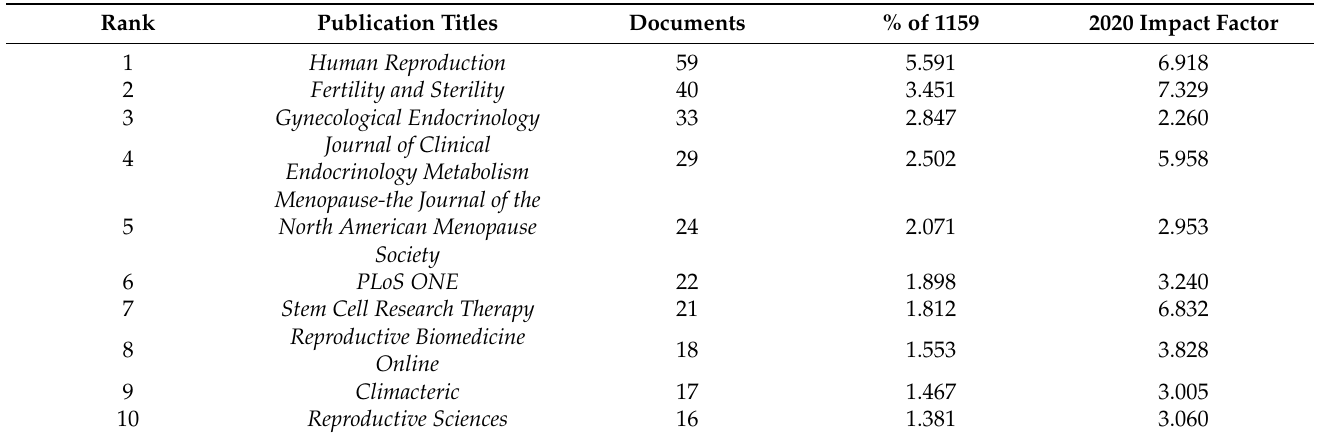
Table 3. Top 10 most productive publications on therapy for POI from 2000 to